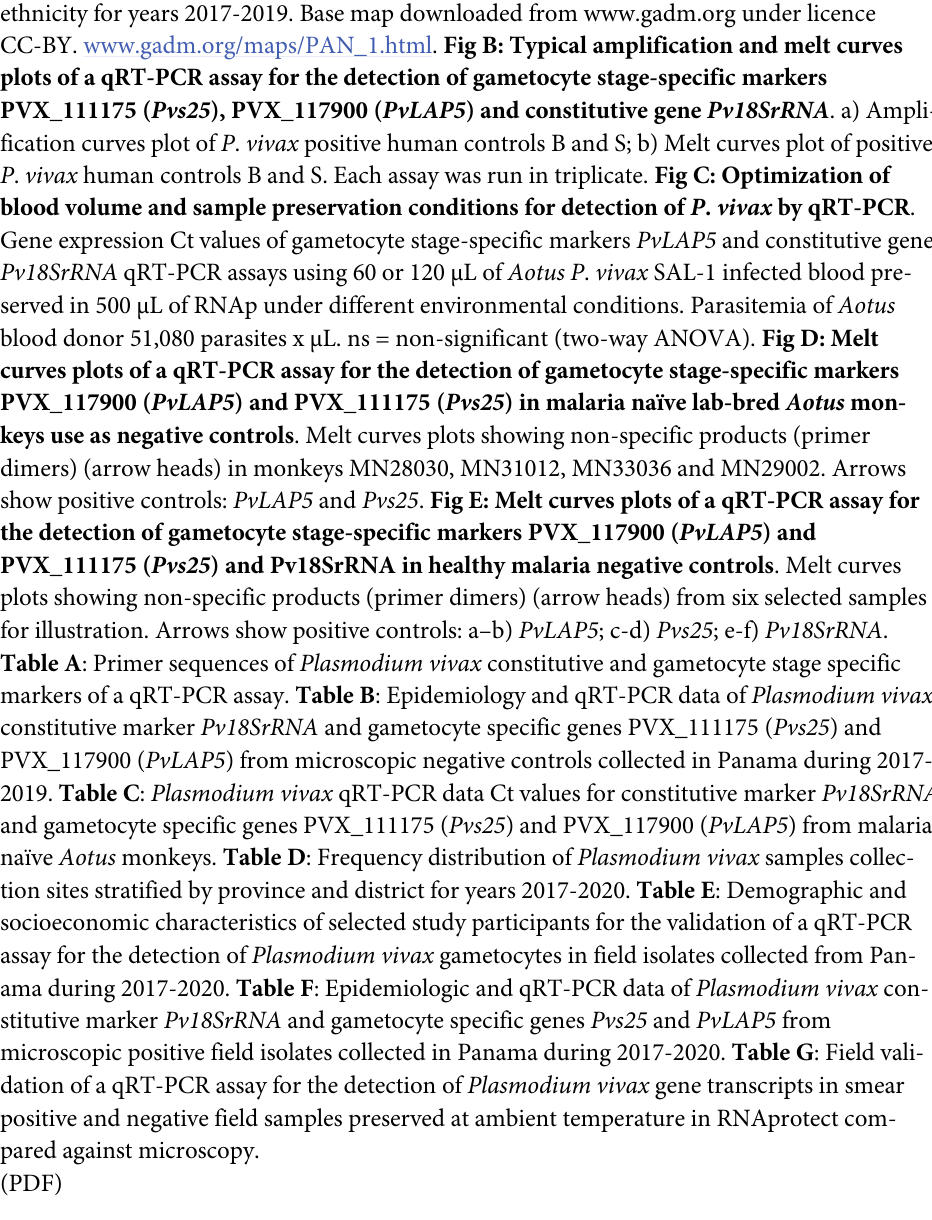
Table A : Primer sequences of Plasmodium vivax constitutive and gametocyte stage specific markers of a qRT-PCR assay. Table B : Epidemiology and qRT-PCR data of Plasmodium vivax constitutive marker Pv18SrRNA and gametocyte specific genes PVX_111175 ( Pvs25 ) and PVX_117900 ( PvLAP5 ) from microscopic negative controls collected in Panama during 2017- 2019. Table C : Plasmodium vivax qRT-PCR data Ct values for constitutive marker Pv18SrRNA and gametocyte specific genes PVX_111175 ( Pvs25 ) and PVX_117900 ( PvLAP5 ) from malaria na ï ve Aotus monkeys. Table D : Frequency distribution of Plasmodium vivax samples collec- tion sites stratified by province and district for years 2017-2020. Table E : Demographic and socioeconomic characteristics of selected study participants for the validation of a qRT-PCR assay for the detection of Plasmodium vivax gametocytes in field isolates collected from Pan- ama during 2017-2020. Table F : Epidemiologic and qRT-PCR data of Plasmodium vivax con- stitutive marker Pv18SrRNA and gametocyte specific genes Pvs25 and PvLAP5 from microscopic positive field isolates collected in Panama during 2017-2020. Table G : Field vali- dation of a qRT-PCR assay for the detection of Plasmodium vivax gene transcripts in smear positive and negative field samples preserved at ambient temperature in RNAprotect